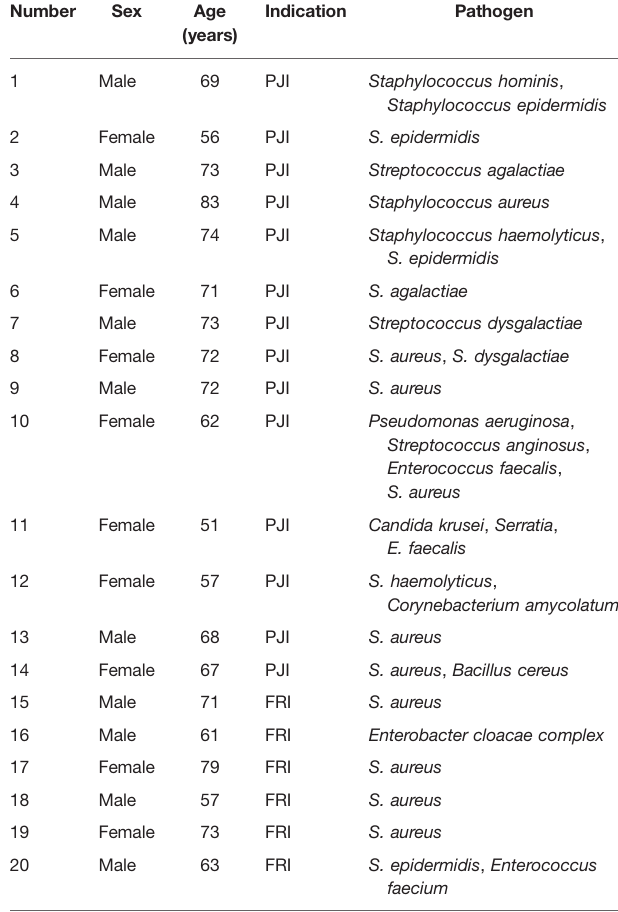
TABLE 1 | Patient